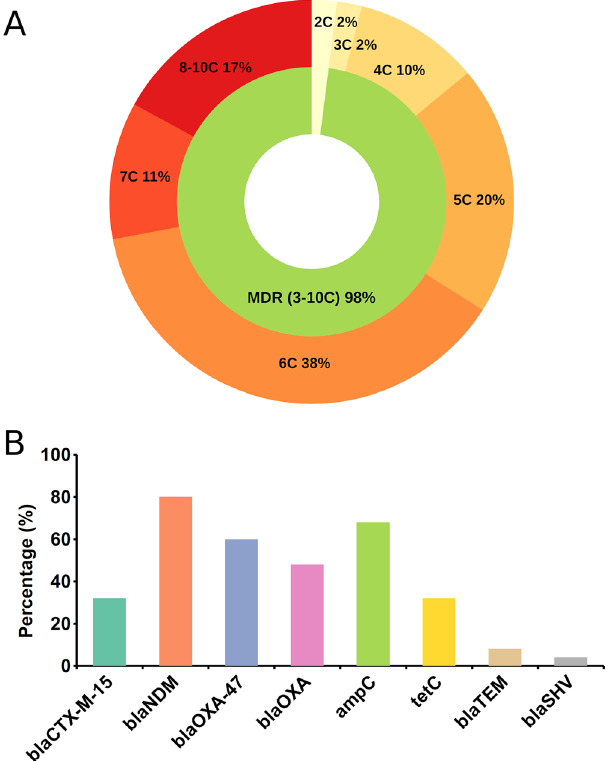
Figure 2. Prevalence of multiple antibiotic resistance among the isolates. ( A ) Distribution of resistance pattern against different classes of antibiotics. ( B ) Prevalence of ARGs among the tested E. coli isolates. C,